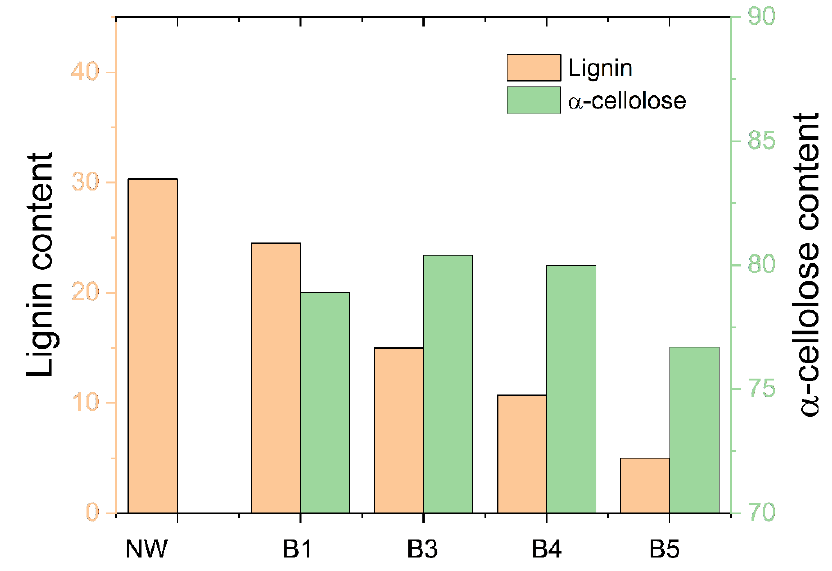
Figure 4. Lignin and alpha-cellulose content with the bleached steps.